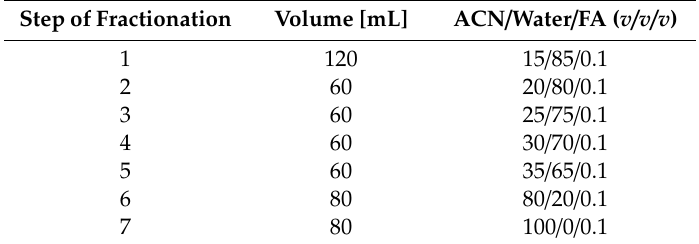
Table 13. Steps of the fractionation of the bacterial eluate by the application of solid phase extraction (SPE).